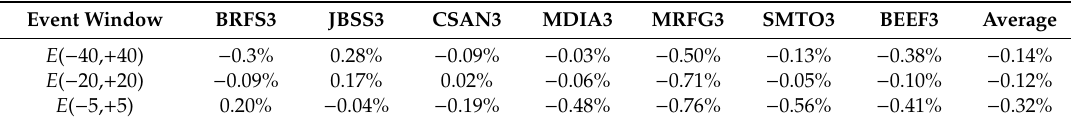
Table 3. Average abnormal returns ( AAR ) for Brazilian